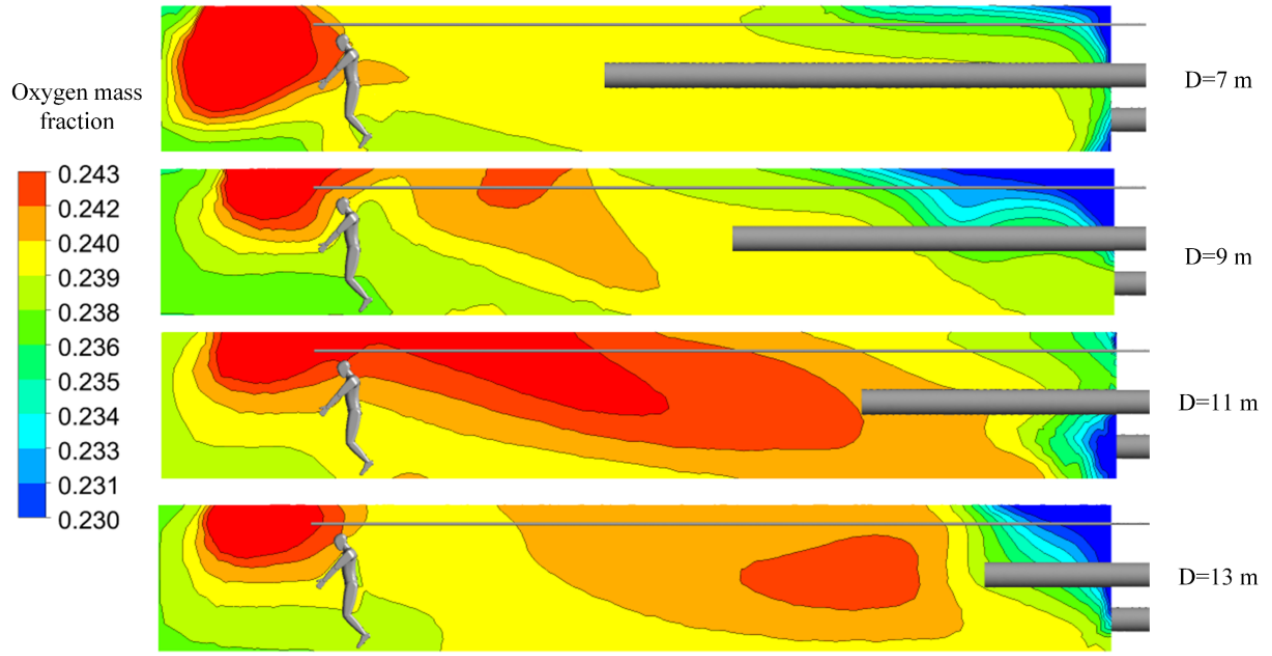
Figure 9. Distributions of oxygen mass fractions at section X = 0 m.